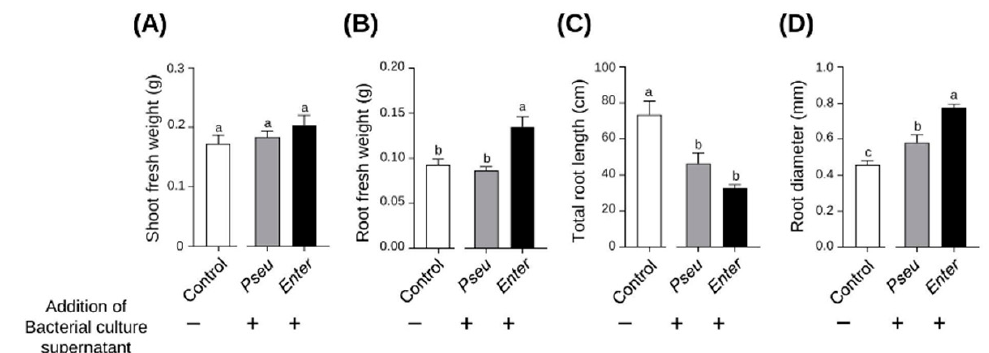
Figure 3. Effects of BPMP-PU-28 ( Pseudomonas urmiensis ) and BPMP-EL-40 ( Enterobacter ludwigii ) culture supernatants on root system development. Durum wheat cv. Anvergur was grown hydroponically in Hoagland solution under axenic conditions. The solution (initial volume: 38 mL) was supplemented with 2 mL of bacterial culture supernatant prepared (filtered to 0.22 µm, thus without bacteria) from a culture (buffered growth medium collected during the stationary phase; see S arrows in Figure S5A, D) of BPMP-PU-28 (Pseu: Pseudomonas urmiensis ) (gray bars) and BPMP-EL-40 (Enter: Enterobacter ludwigii ) (black bars), or was supplemented with 2 mL of a mock medium (not used for bacterial growth: control; white bars). ( A ) Shoot fresh weight, ( B ) root fresh weight, ( C ) total root length and ( D ) root diameter after 7 days of growth. Total root length and diameter were determined using WinRHIZO. Means ± SE (n = 5). Different letters indicate statistically significant differences (one-way ANOVA test, p ≤ 0.05).